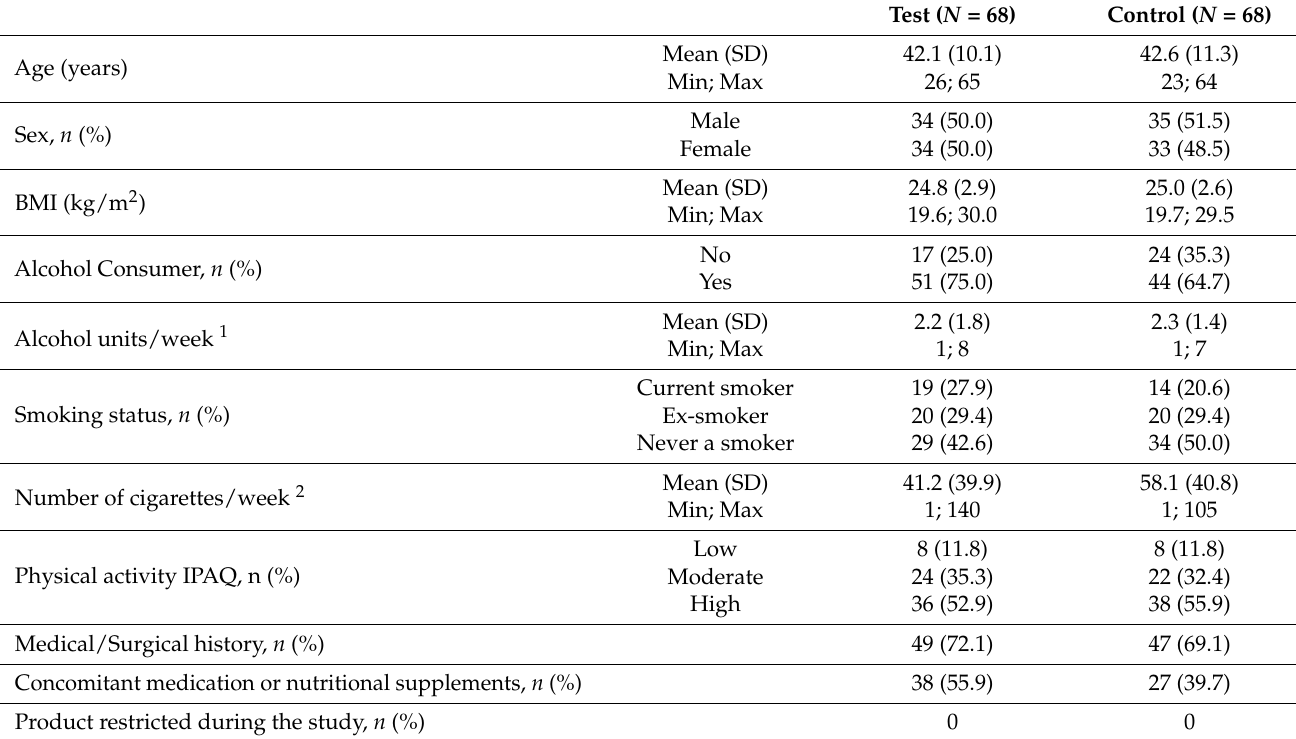
Table 1. Subject characteristics at